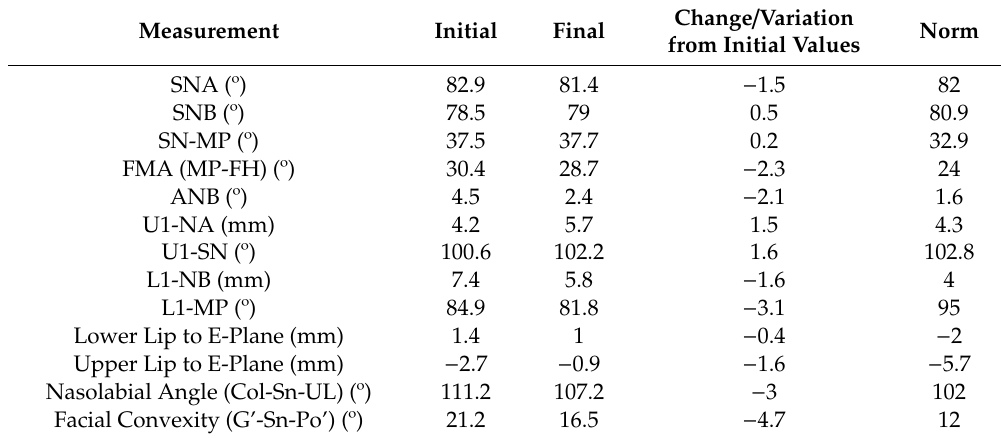
Figure 4. ( A ) Initial photographs showing convex profile with recessive chin and anterior crowding. ( B ) Initial digital models showing Class II Division 2 subdivision left side malocclusion with increased overbite and excessive curve of Spee. ( C ) CBCT-driven cephalometric radiograph showing convex profile with recessive chin and normally positioned upper incisors / nasolabial angle. ( D ) CBCT panoramic radiograph showing presence of all permanent teeth except lower third molar germs; no other noticeable intraoral bony lesion could be detected. ( E ) CBCT-driven sagittal screen of lower incisor showing increased overbite. ( F ) The digital treatment plan (ClinCheck) showing posterior teeth intrusion to help forward rotation of the mandible. ( G ) Upper arch digital treatment plan (ClinCheck) showing expansion and labial movement of the upper arch (blue—initial teeth position, white—final teeth position). ( H ) Lower arch digital treatment plan (ClinCheck) showing expansion (blue—initial teeth position, white — final teeth position) and lower anterior interproximal reduction to allow lower incisor intrusion and leveling / alignment of lower incisors. No attempt was made to procline the lower incisors. ( I ) Final photos showing improved patient’s profile and chin projection as well as aligned upper and lower incisors and Class I buccal occlusion both sides. Additionally, over bite has been improved compared to initial records. ( J ) CBCT-driven final cephalometric radiograph showing improved profile and chin projection. ( K ) Final CBCT-driven panoramic radiograph. ( L ) Final CBCT-driven sagittal screen radiograph of upper and lower incisors showing improved overbite and bone labial to both upper and lower incisors. ( M ) Superimposition of cephalometric tracing of before (black) and after (red) treatment showing improved forward chin projection, palatal movement of upper incisors roots while upper molars and incisors crowns moved forward by the dental decompensation, and profile and chin projection and lingual tipping of lower incisors. Table 4. Before-and-after treatment cephalometric analyses of Case